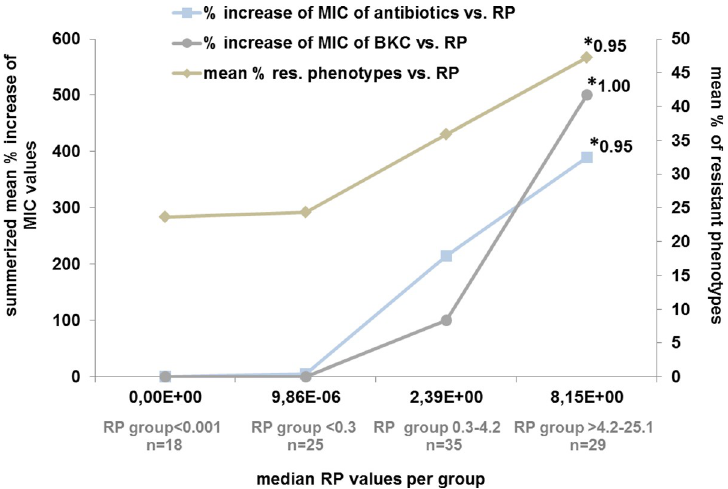
Fig 4. Correlation of intI1 prevalence (RP) vs. increase of MIC to antibiotics and benzalkonium chloride (BKC) and percentage of resistant phenotypes per RP group. The left Y-axis depicts the summarized mean % increase of MIC value per RP group, the right Y-axis depicts mean % of resistant phenotypes per group. � Spearman correlation. Please see method section for RP